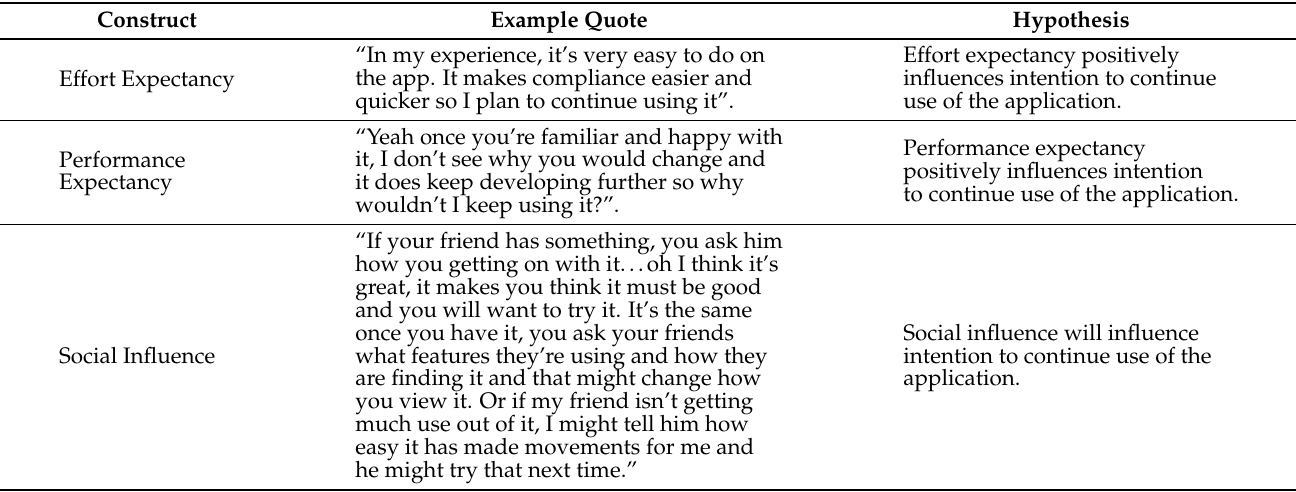
Table A3. User focus